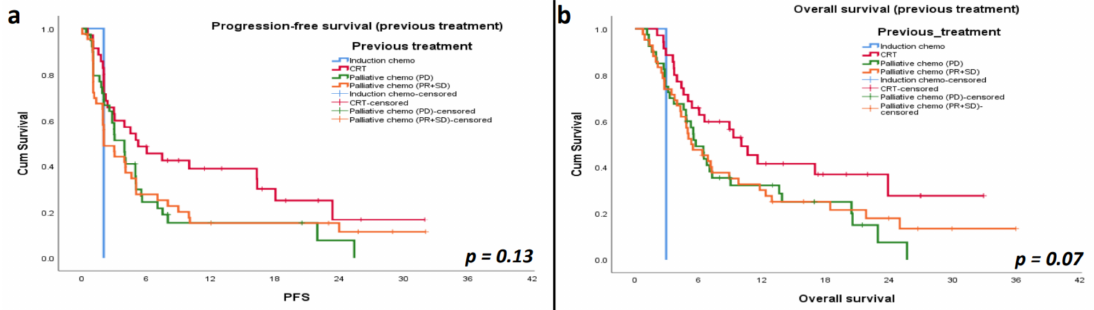
Figure A1. Kaplan–Meier curves for ( a ) progression-free survival and ( b ) overall survival in patients in the nivolumab group based on previous